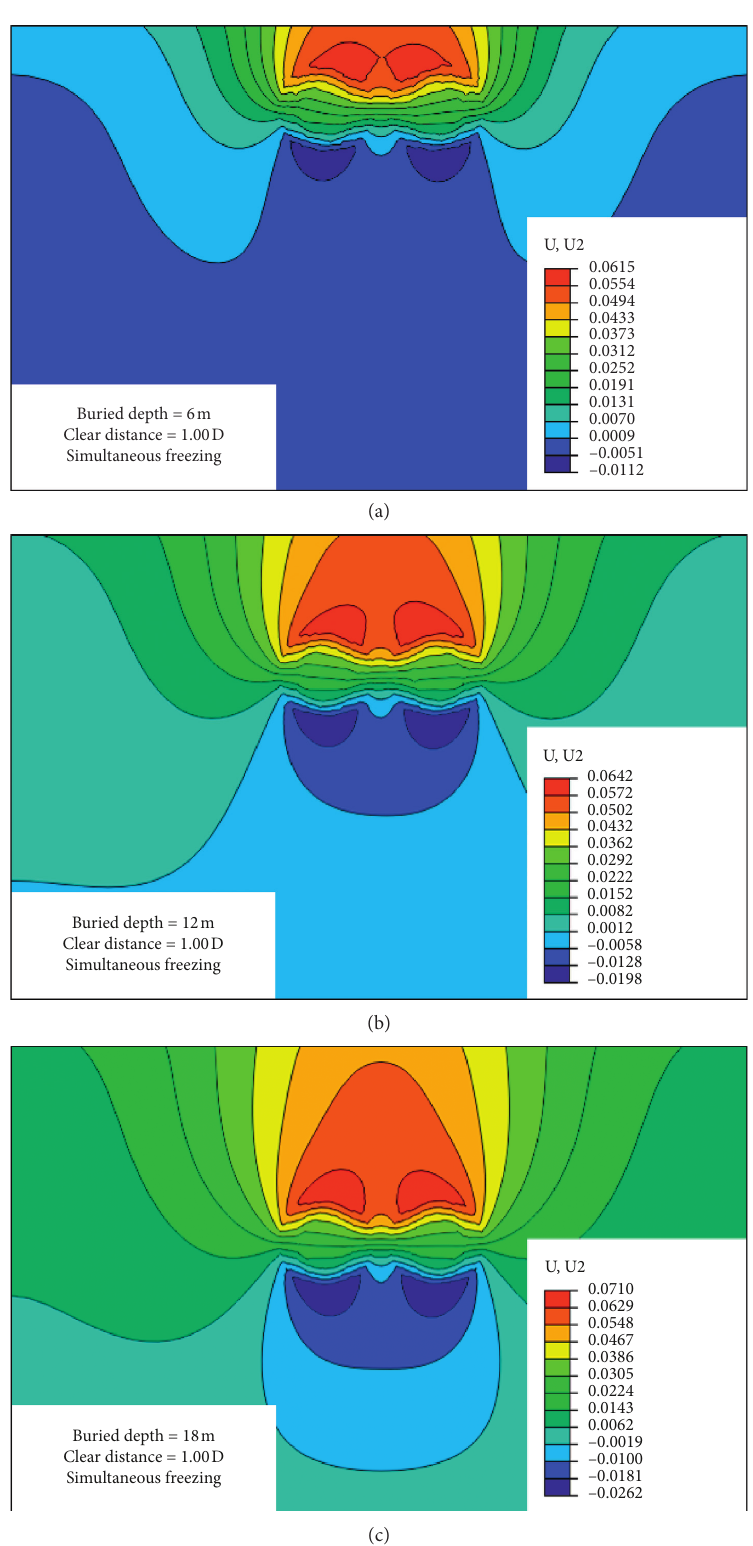
Figure 7: Vertical displacement field of the ground (unit: